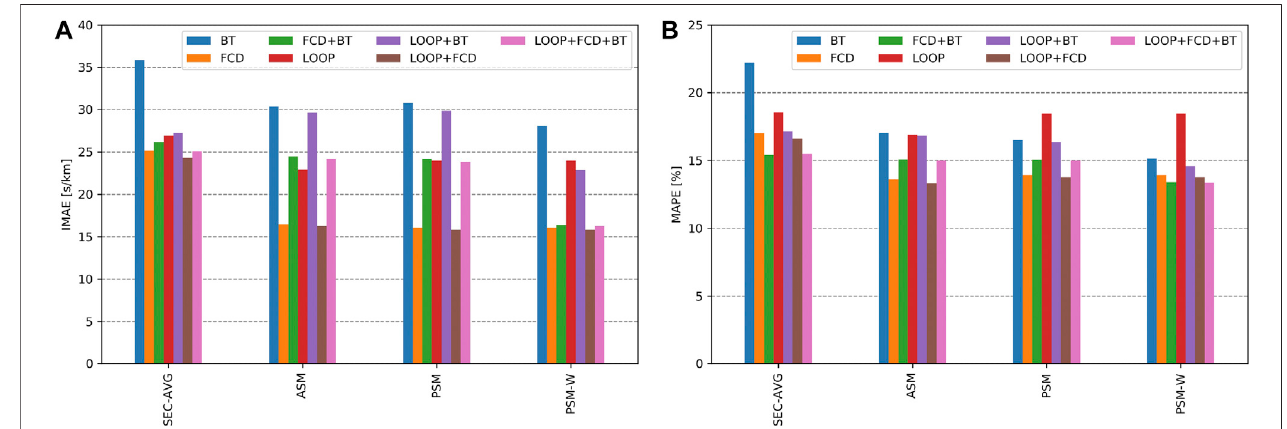
FIGURE 5 | Mean (A) IMAE and (B) MAPE of all runs with respect to the available sensor technology and the applied algorithm.